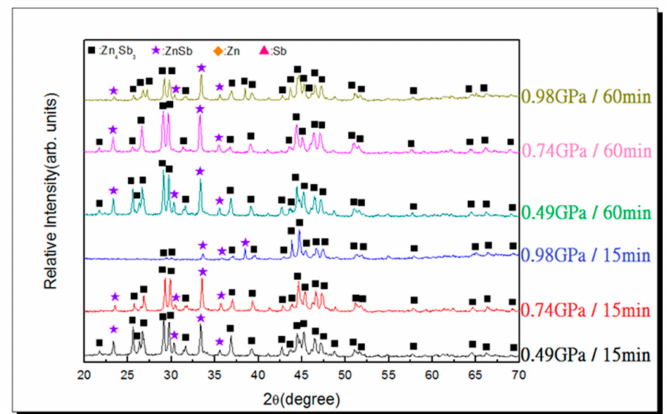
Figure 4. XRD patterns of bulk specimens with 0.6 at. % Zn rich composition hot pressed at 473 K under different pressures and times.